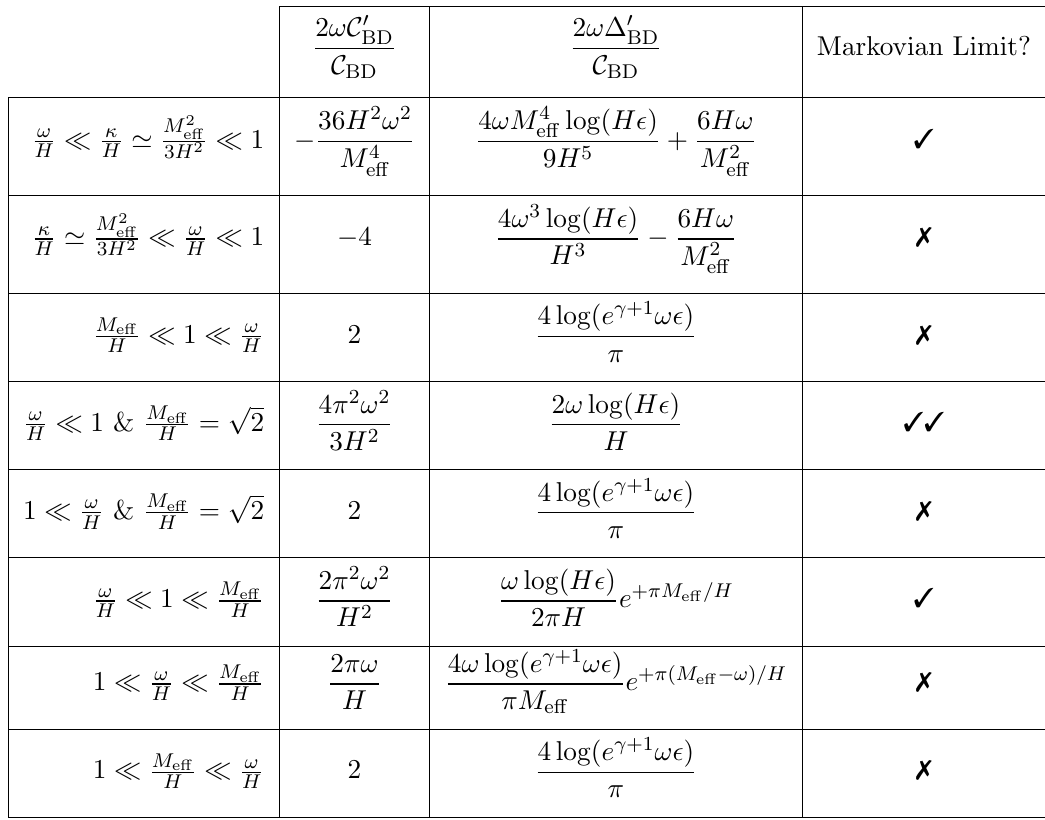
Table 3 . Asymptotic forms in di(cid:11)erent parameter regimes for the two g -independent conditions for the validity of the Markov approximation, as computed using the asymptotic forms provided in table 2. The third column indicates whether parameters exist that make the previous two terms small, without checking whether or not (3.25) is also satis(cid:12)ed. Two checks indicate cases where !=H is not required to be small in an M e(cid:11) =H -dependent way. (Notice in particular that checks only appear in regimes where !=H is